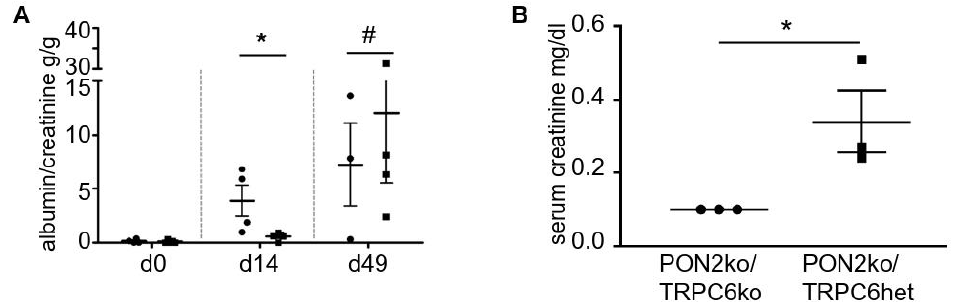
Figure 6. Aggravation of the adriamycin-induced nephropathy phenotype in PON2 knockout is mediated by TRPC6. ( A ) Quantitative analysis of albuminuria in PON2/TRPC6 double knockout (squares) and PON2 ko/TRPC6 heterozygous (circles) mice. While PON2ko/TRPC6het mice develop albuminuria on day 14, PON2ko/TRPC6ko mice are protected ( n = 4 and 5, respectively; * p < 0.05, # not significant). In the further course, mice of both genotypes show progressive nephrotic proteinuria. ( B ) Quantification of serum creatinine on day 49 show increased concentrations in PON2ko/TRPC6het mice as compared to PON2ko/TRPC6ko ( n = 3; * p < 0.05).